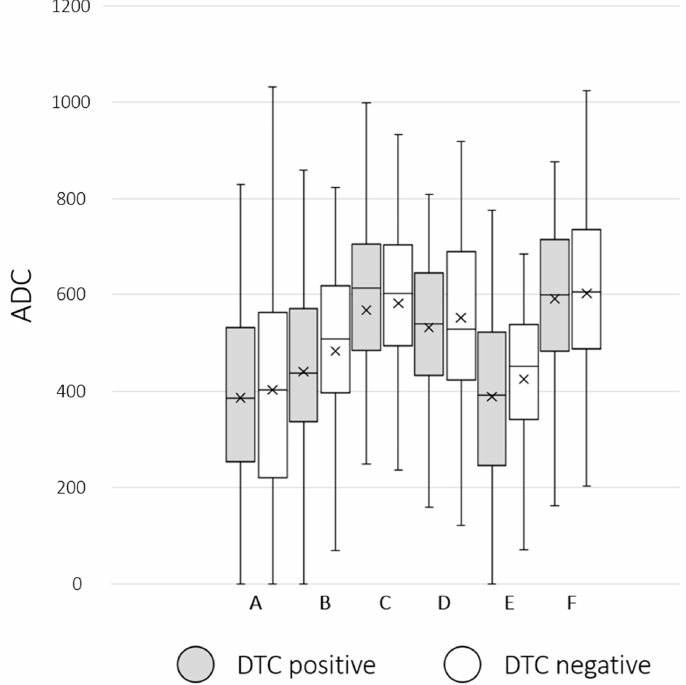
Figure 6. Group comparison between DTC (disseminated tumor cells)-positive (grey box) and DTC- negative (white box) patients regarding ADC mean bone marrow values: ( A ) right femur ADC mean , ( B ) os sacrum-ADC mean , ( C ) right os ilium ADC mean , ( D ) L 5-ADC mean , ( E ) T 7-ADC mean , and ( F ) sternum-ADC mean . The crosses indicate the mean value. No significant differences in group comparison were visible.